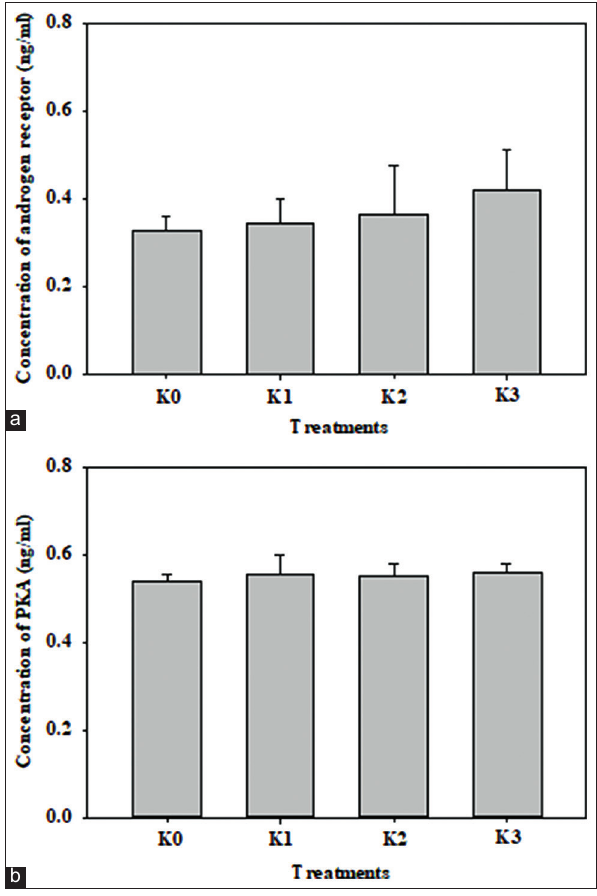
Figure-1: The concentration (mean ± SD) of the androgen receptor (a) and protein kinase A (b), after injected with a combination of the epididymis and testicular extracts in male chicken. There was no significant difference between groups (p>0.05). K0= chickens were injected with 1 mL normal saline, K1= chickens were injected with 1 mL combination of the epididymis and testicular extracts, K2= chickens were injected with 2 mL combination of the epididymis and testicular extracts, K3= chickens were injected with 3 mL combination epididymis and testicular